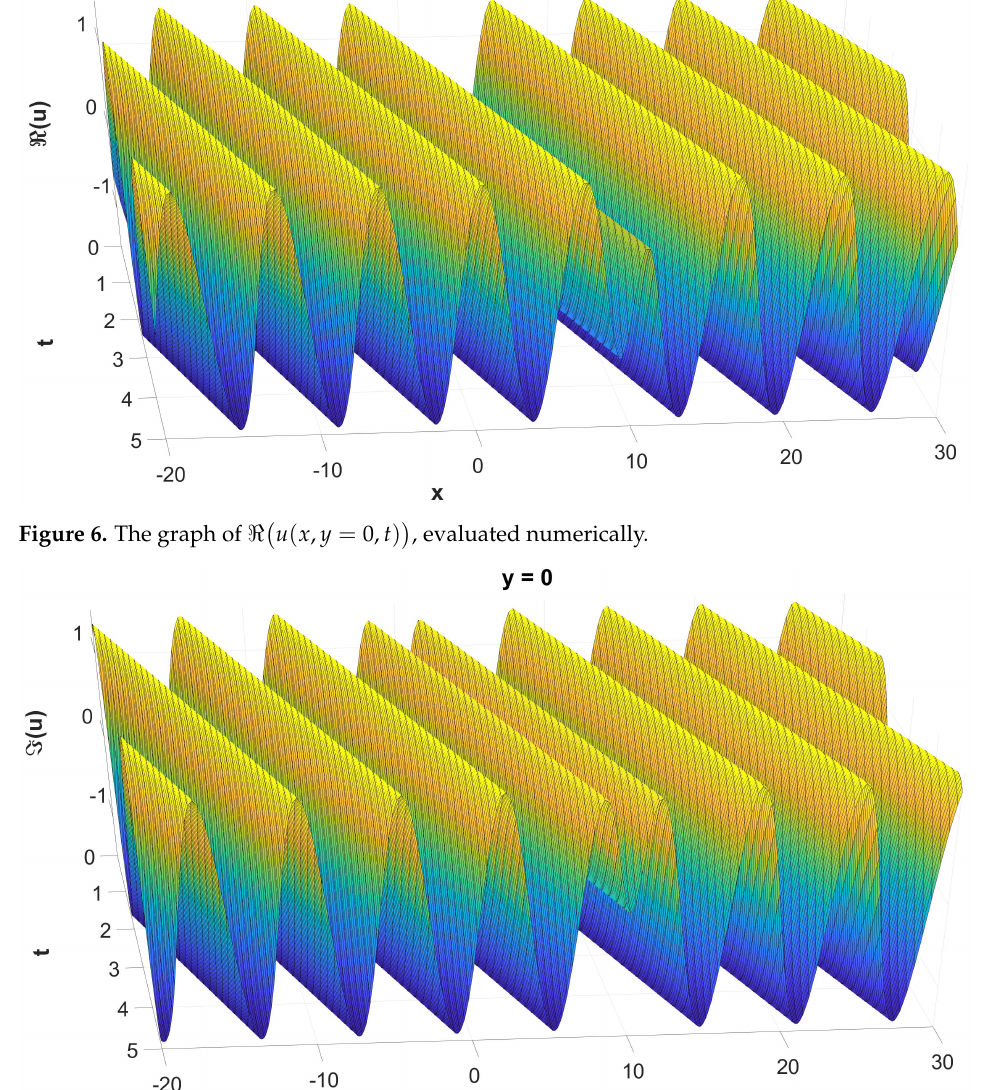
(cid:0) (cid:1) u ( x , y = 0, t ) , evaluated